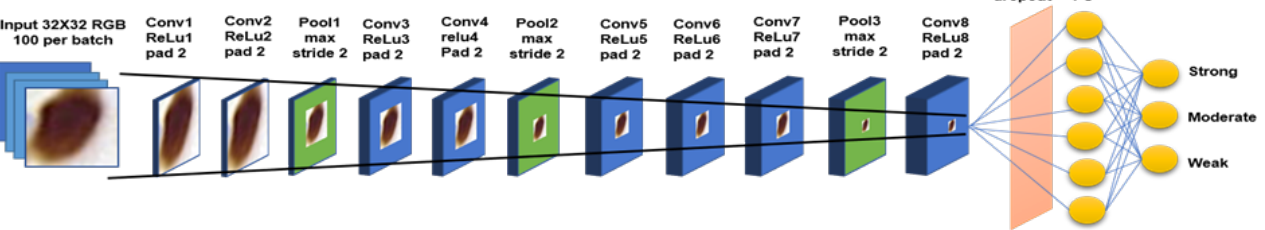
Figure 4. Our proposed 9-layer convolutional layer including the fully connected